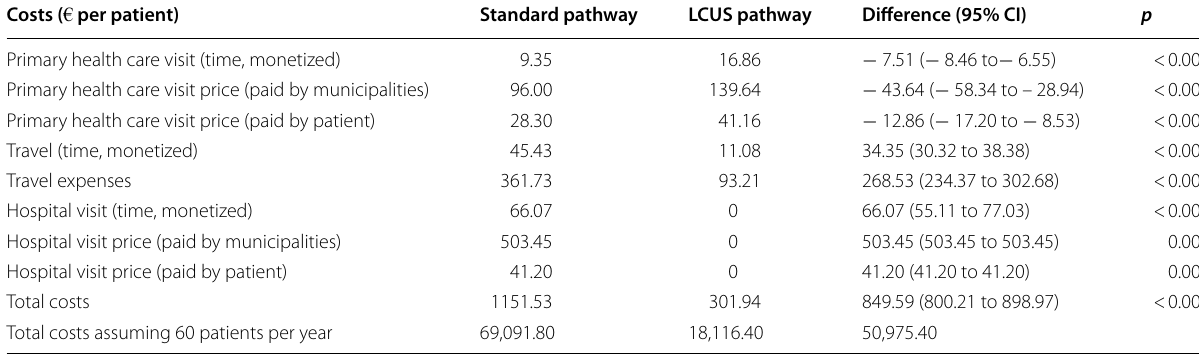
Table 3 Cost calculator demonstrating the cost-minimization modeling on different diagnostic pathways